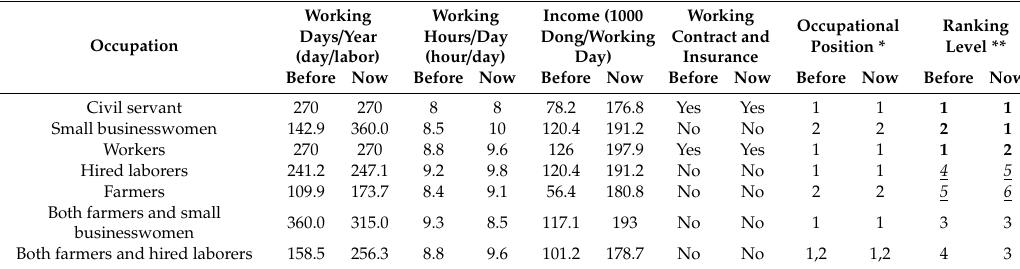
Table 3. Aspects of occupation of rural women before ALA and at